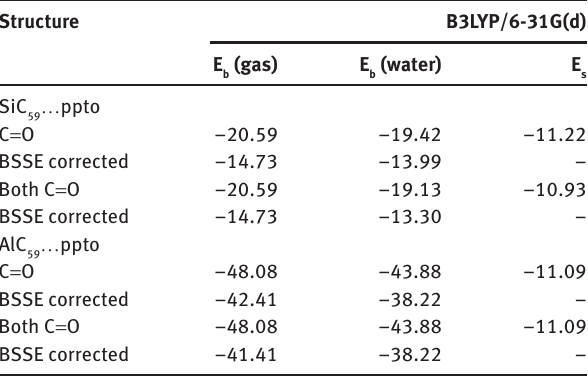
Figure 1: ESP map of ppto.